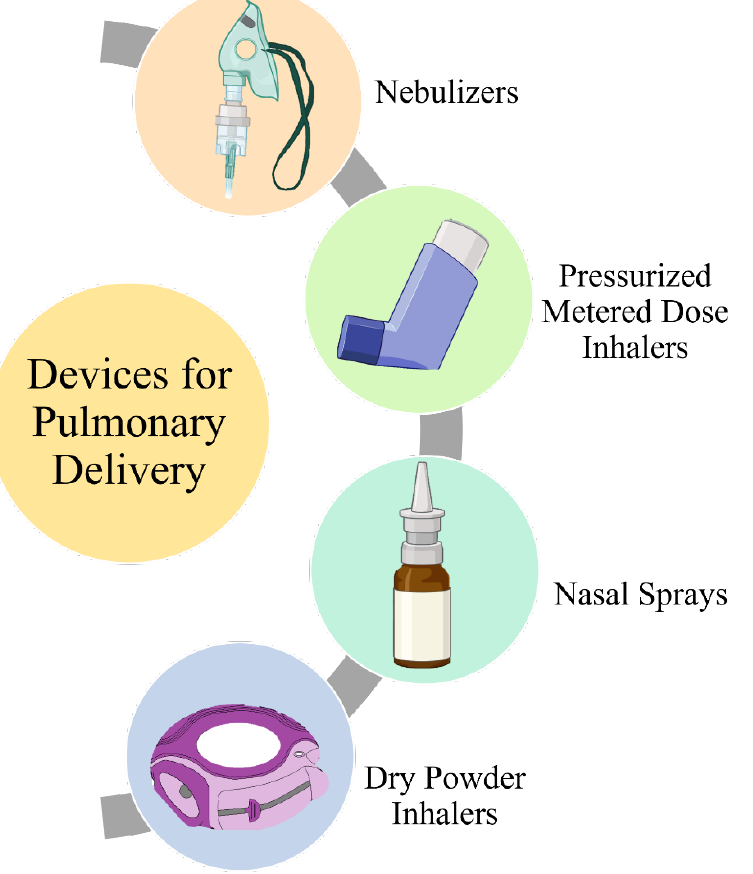
Figure 8. The different devices employed for pulmonary delivery of anticancer agents.